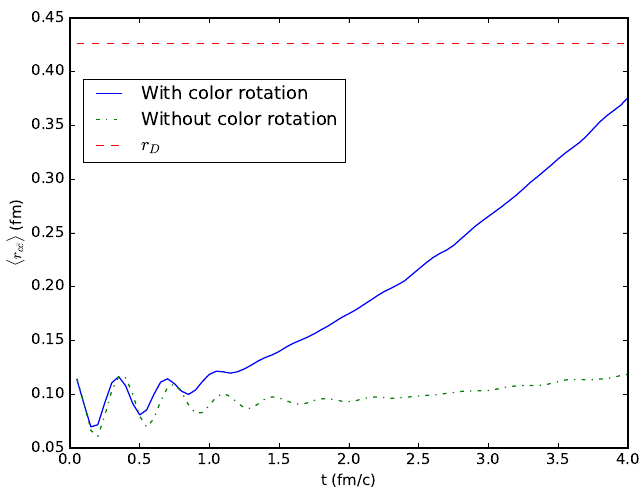
Figure 13 . Comparison of the evolution of a pair of heavy quarks initially prepared in a J= (cid:9) state with or without considering the transition into octet states. The screening radius is r D = m (cid:0) 1